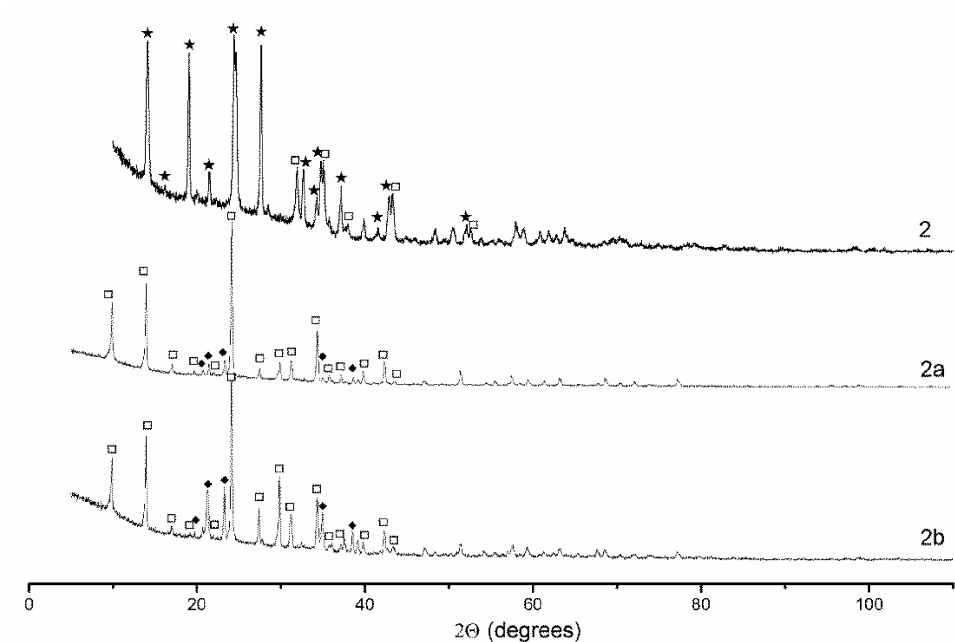
Figure 30. Powder X-ray diffraction patterns of the products of Experiments 2, 2a and 2b. The characteristic non-overlapping reflections of cancrinite-type ( (cid:3) ), sodalite-type ( (cid:70) ) and nepheline- type ( (cid:7) ) phases are indicated.